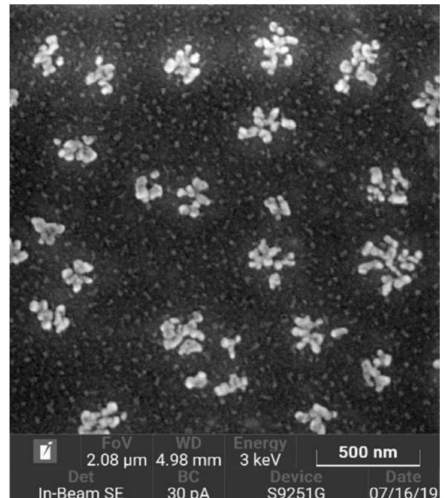
Figure1. Scanningelectronmicroscopy(SEM)imageofchitosannanoparticles. Clustersofnanoparticles are not aggregates but individual particles that have come together during